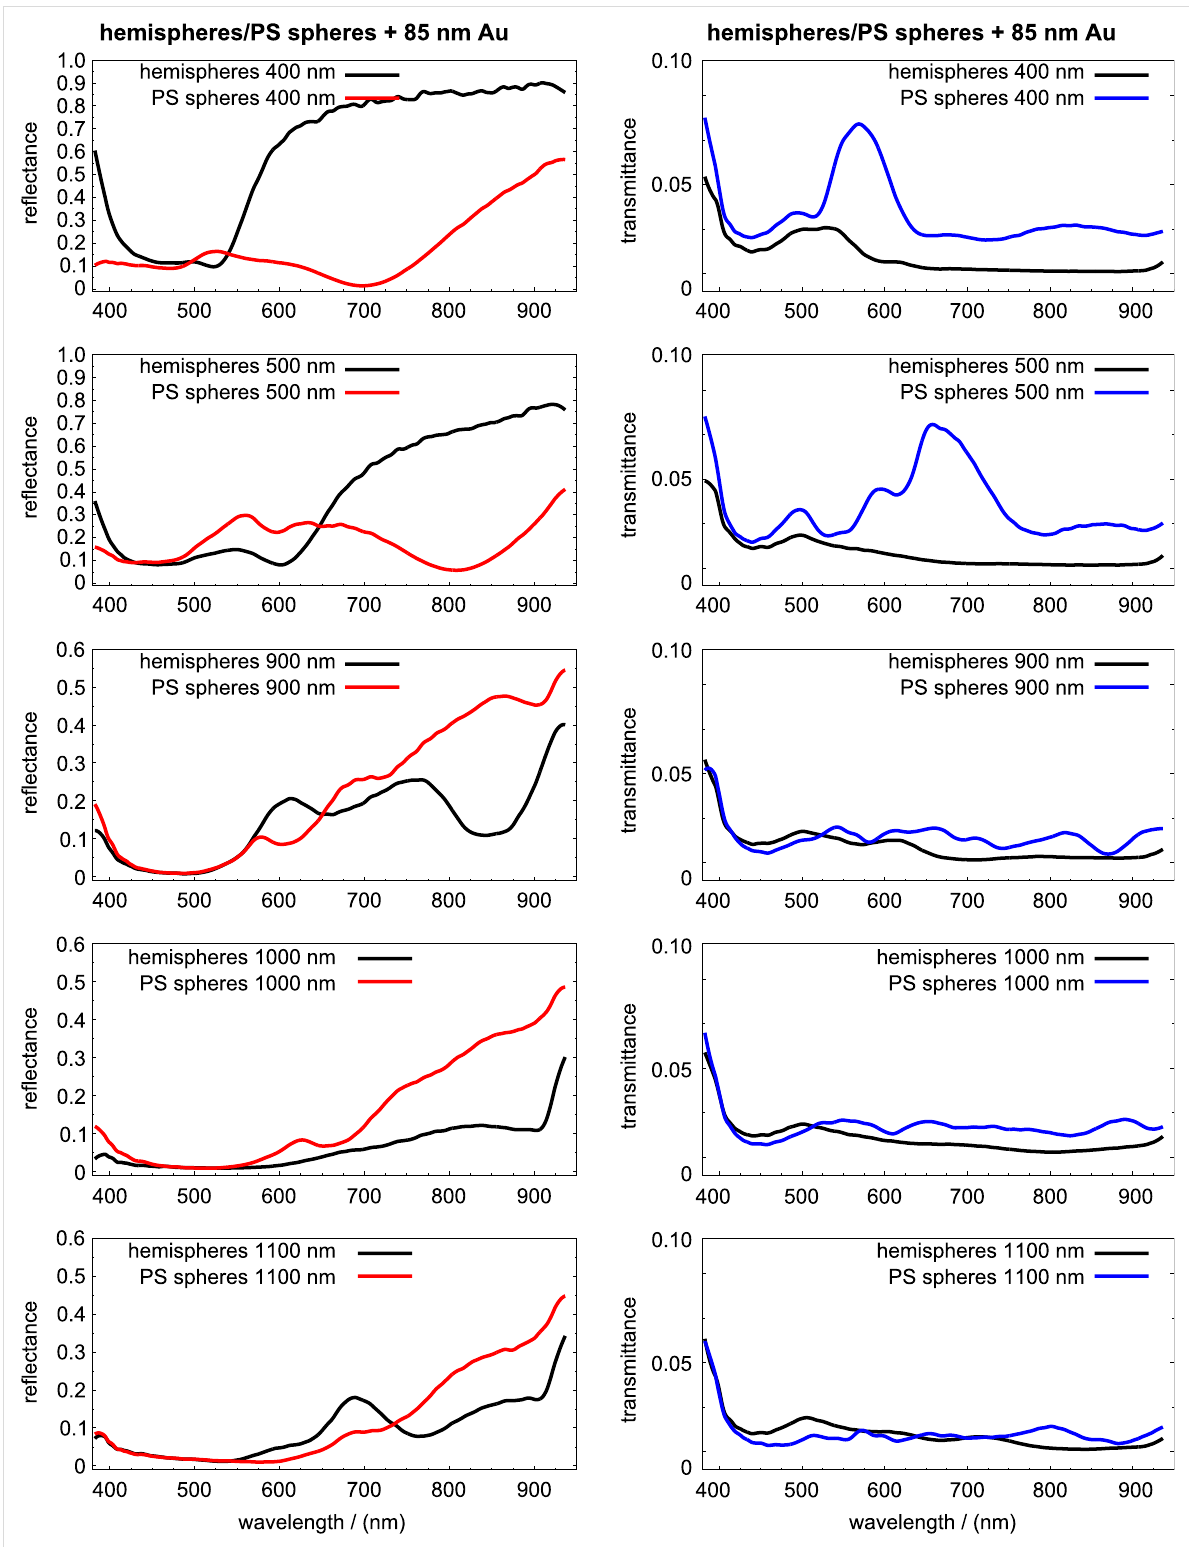
Figure 3: Reflectance (left) and transmittance (right) obtained at vertical illumination with an objective of NA = 0.25. The diameter of the PS spheres or hemispheres is indicated in the legend of each spectrum. The thickness of the gold film is approximately 85